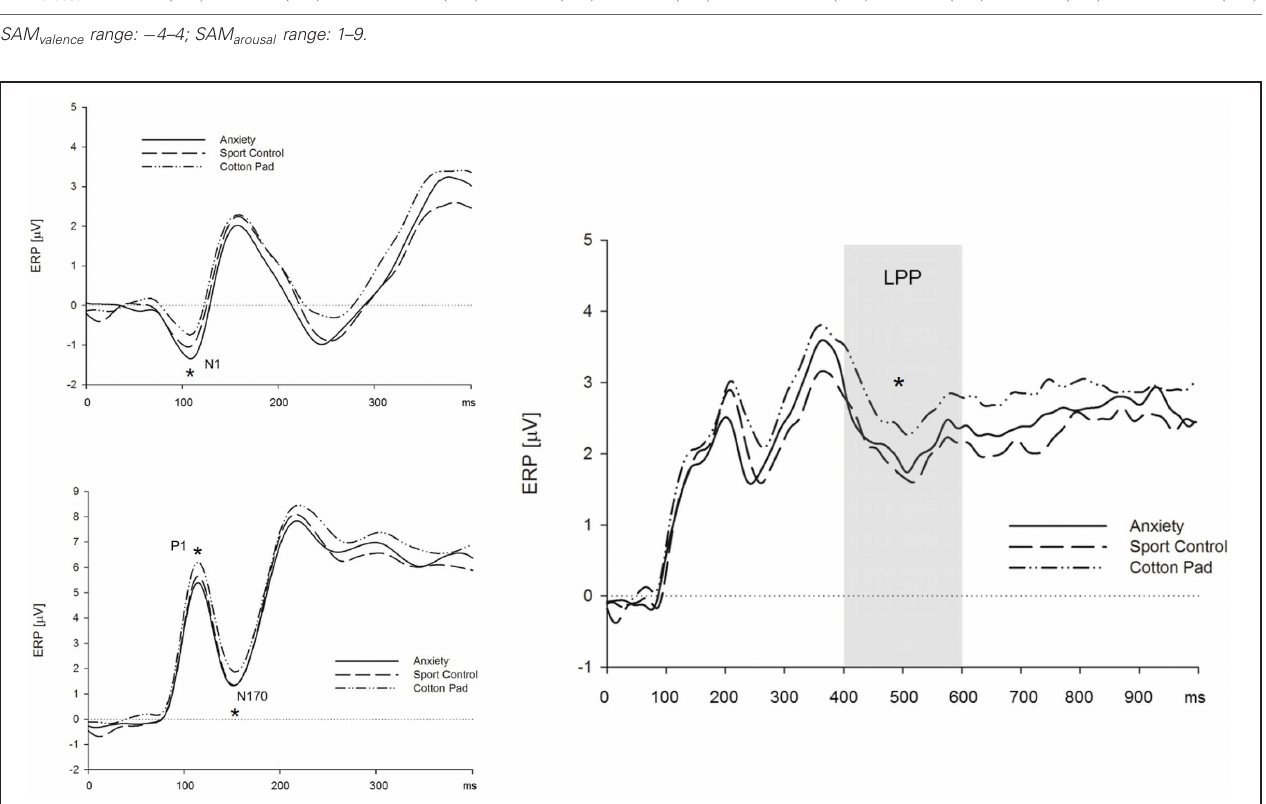
scalp locations), and larger N170 potentials (occipital and parietal scalp locations), but smaller LPPs (recorded at all electrode locations). ∗ N1 = 0.041; ∗ P1 = 0.004; ∗ N170 = 0.046; ∗ LPP =